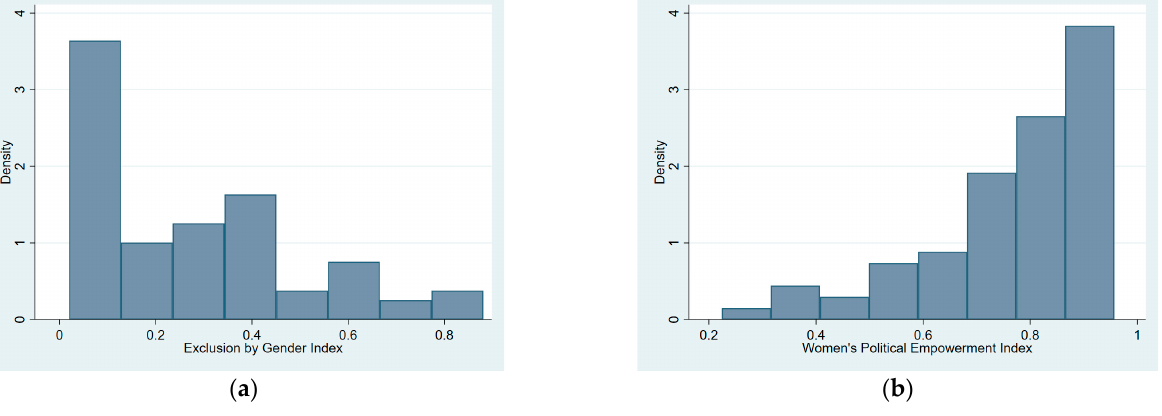
Figure A1. Distribution of the Exclusion by Gender (EG) Index ( a ) and the Women’s Political Empowerment (WPE) Index ( b ). One observation per country is included. Source: WVS-EVS data set.